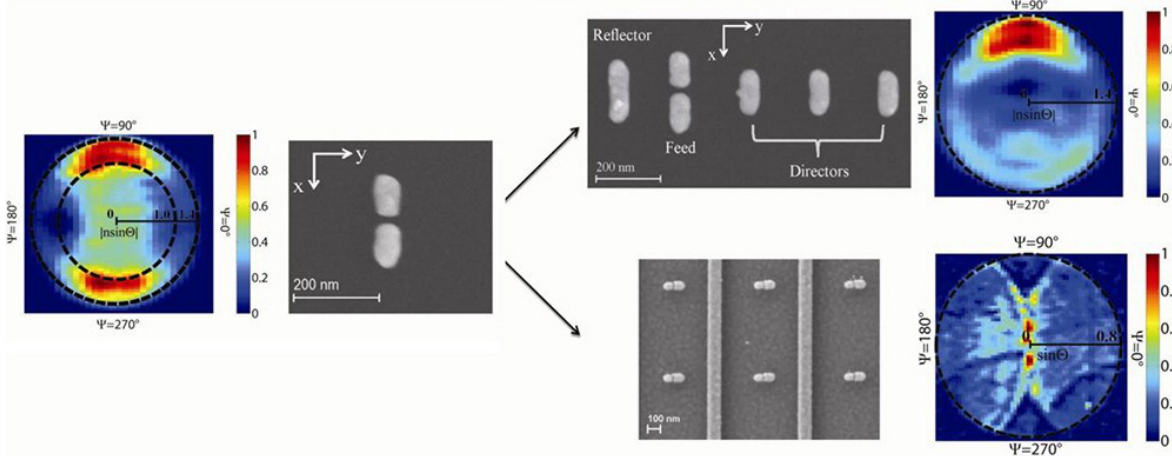
Figure 14. Raman emission pattern from YU antennas on dielectric substrate. SEM and measured emission pattern of thiophenol 1074 cm −1 Raman line retrieved from energy momentum spectroscopy measurements. Color map represents the scattering intensity normalized by the maximum intensity. Inner and outer black dashed circles indicate the critical angle at the air-glass interface and the numerical aperture of objective lens,